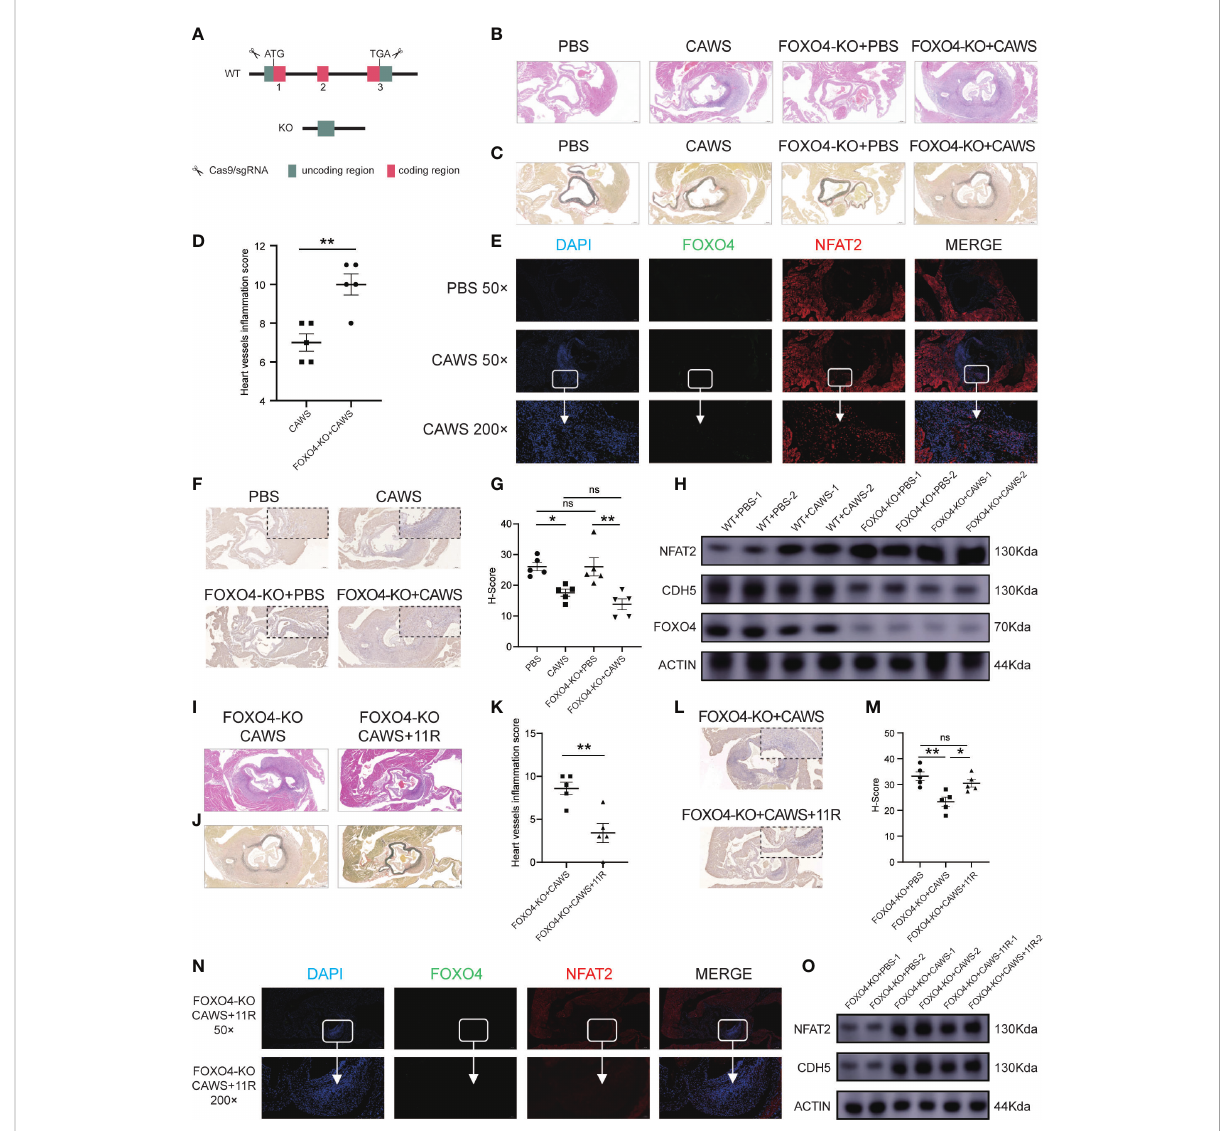
FIGURE 7 FOXO4-KO mice could exacerbate the vasculitis induced by CAWS, but the in fl ammation was relieved after blocking NFAT2. (A) The Cas9/gRNA method generated the FOXO4-KO mice. (B – D) Different groups of mice were sacri fi ced and heart tissues were harvested, made into section sections, and subjected to hematoxylin and eosin (HE)-staining (B) and elastic van Gieson (EVG) staining (C) . Heart vessel in fl ammation scores of FOXO4-KO and WT mice in different groups were analyzed (D) (n = 5). (E) Immuno fl uorescence staining for FOXO4 (green) and NFAT2 (red) in heart sections of the PBS/CAWS-injected FOXO4-KO group mice. All images show DAPI staining of nuclei. (F) Immunohistochemical staining for CDH5 in heart sections from four different groups. (G) The CDH5 protein level quanti fi ed by the H-score (n = 5). (H) Western blotting determination of NFAT2, FOXO4, and CDH5 protein levels in different groups. The loading control comprised b -Actin. Different groups of FOXO4-KO mouse were sacri fi ced, and heart tissues were harvested and made into sections, which were subjected to HE staining (I) and EVG staining (J) sections. (K) Heart vessel in fl ammation scores of FOXO4-KO+CAWS, and FOXO4-KO+CAWS+11R mice were analyzed (n = 5). (L) Immunohistochemical staining for CDH5 in heart sections from different FOXO4-KO groups. (M) CDH5 protein levels quanti fi ed by the H-score (n = 5). (N) Immuno fl uorescence staining for FOXO4 (green) and NFAT2 (red) in heart sections from FOXO4-KO+CAWS+11R-injected group mice. All images show DAPI staining of nuclei. (O) Western blotting analysis of NFAT2 and CDH5 levels in different FOXO4-KO mouse groups. The loading control comprised b -Actin. Scale bars, 200 µm (50×) and 10 µm (200×). Data are presented as the mean ± SEM. Quantitative data were analyzed using unpaired t tests (two-tailed) (D, K) and one-way ANOVA (E, M) , *P < 0.05, **P <